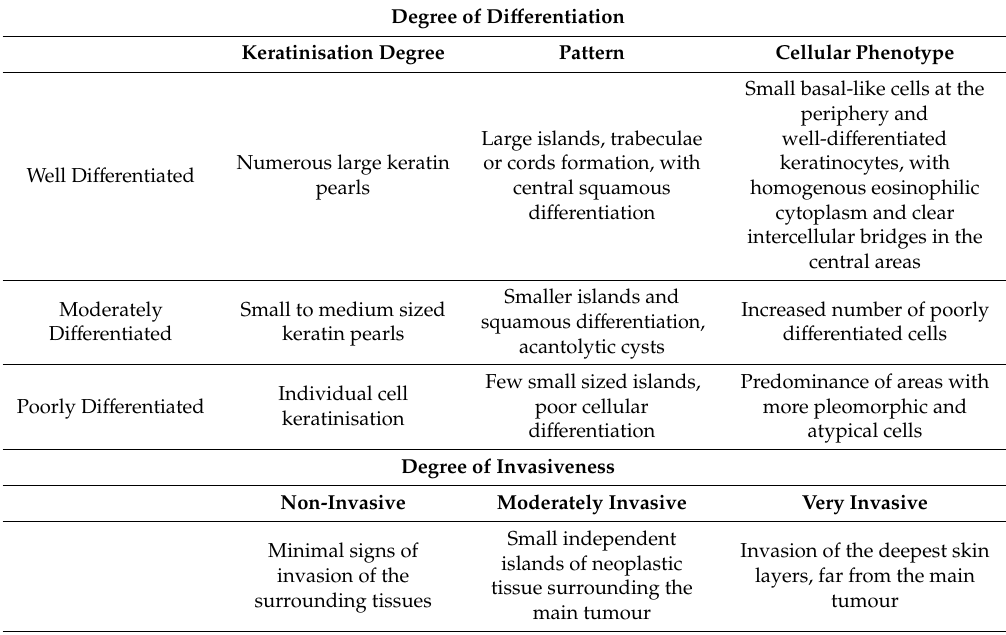
Table 1. Bovine Ocular Squamous Cell Carcinoma (BOSCC) histopathological classification regarding degree of di ff erentiation and invasiveness [11,38–40].